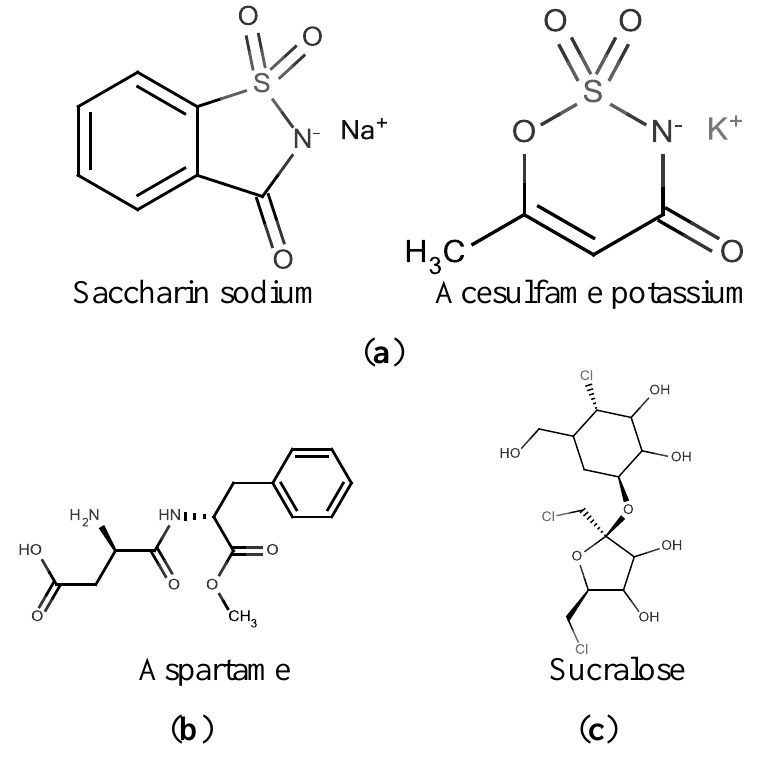
Figure 1. Four typical high-potency sweeteners. They are classified in three types by the electric charge under acidic conditions. ( a ) Negatively charged high-potency sweeteners; ( b ) Positively charged high-potency sweeteners; ( c ) No electrical charge high-potency